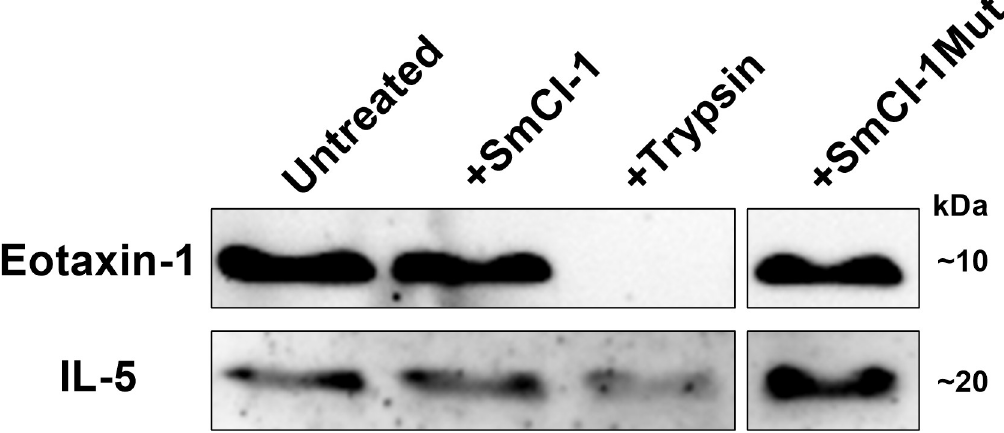
Fig 8. S . mansoni invadolysins do not cleave key cytokines. Western blots containing 50ng/lane recombinant human cytokines treated with 1 μ g/ml of the indicated proteases and probed with relevant monoclonal antibodies. Trypsin degrades Eotaxin-1 while the invadolysins do not. IL-5 was weakly affected by trypsin, and not degraded by either the wild type or mutant rSmCI-1.